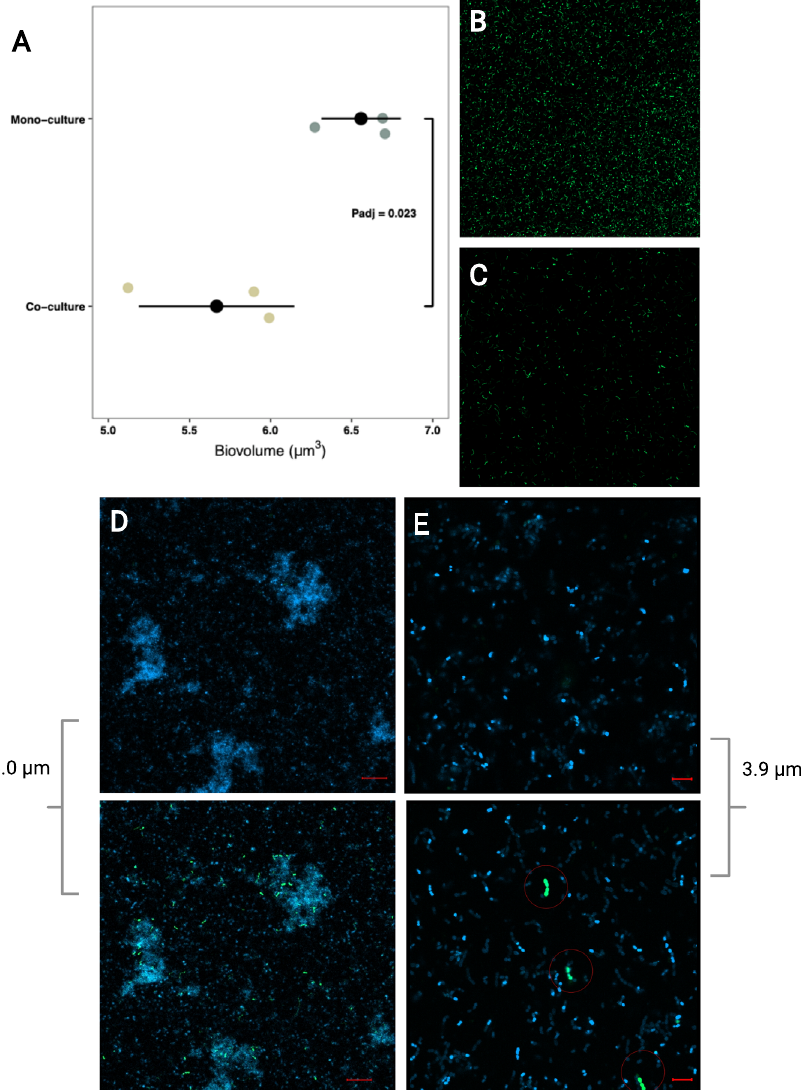
Fig. 2 CLSM quanti fi cation of Lactococcus lactis abundance and localization on glass slides. A Numbers of L. lactis harboring pNAMA_P32- sfgfp(Bs)-CmR were lower when co-cultivated with L. mesenteroides on a glass surface compared to those of the single culture ( P adj = 0.023, Welch Two Sample t test, N = 3). Quanti fi cation of biovolume was performed using RCon3D and all replicates were imaged in a fi xed volume of space ( X : Y : Z 319.45 µm:319.45 µm:12 µm). The x-axis shows the log10 transformed biovolume. B , C Representative CLSM images of sfGFP (Bs)-expressing L. lactis incubated in mono culture and in co-culture with L. mesenteroides , respectively. D Visualization of DAPI-stained co- culture of L. mesenteroides and sfGFP (Bs)-expressing L. lactis con fi rmed that L. lactis was only present at the bottom in close proximity to the glass surface, while L. mesenteroides was still present 5 µm above (×20 magni fi cation, scale bar represents 20 µm. Bottom image was acquired near the glass surface, top image is 5 µm above). E The observation in D was also evident with higher magni fi cation (×63 magni fi cation, scale bar represents 5 µm. Bottom image was acquired near the glass surface, top image is 3.9 µm above). Red circles in bottom image indicate L. lactis cells observed near the glass